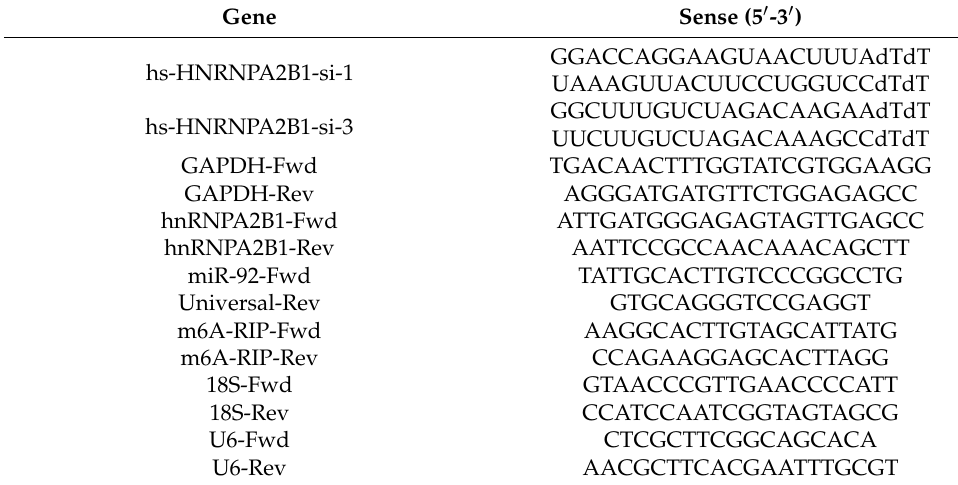
Table A4. siRNA and RT-qPCR